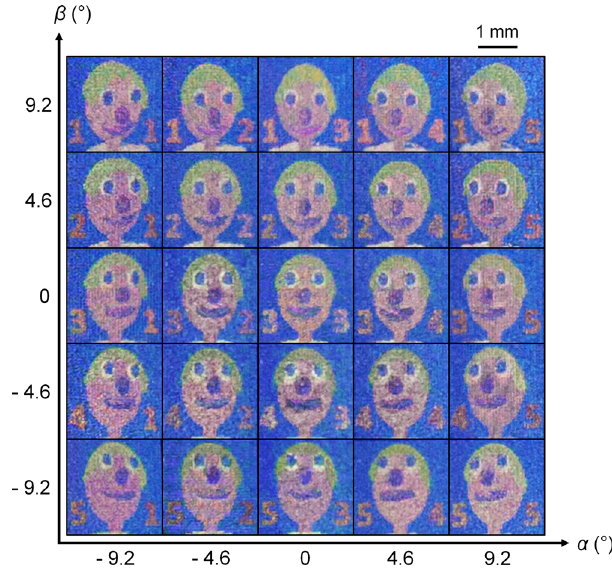
Fig. 5 Light fi eld print encoded with 5 × 5 perspectives of a computer- generated cartoon face. Digital camera macro images of the cartoon face were captured from each viewpoint denoted by azimuthal angle α and elevation angle β . The cartoon face appeared to protrude out of the plane of the substrate. In this light fi eld print, each colour pixel comprised 3 × 3 nanopillars (pixel pitch P = 3 µ m). The same scale bar applies to each viewpoint